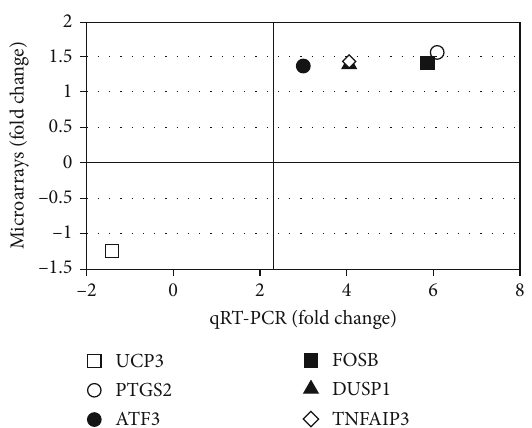
Figure 3: Comparison of fold change values (T1D versus control group), obtained by the microarrays and qRT-PCR methods, for the selected di ff erentially expressed mRNAs.